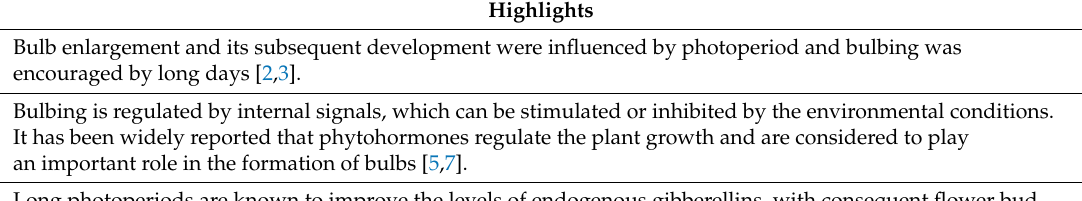
Table 1. Bulbing response to the photoperiod and its mechanism.